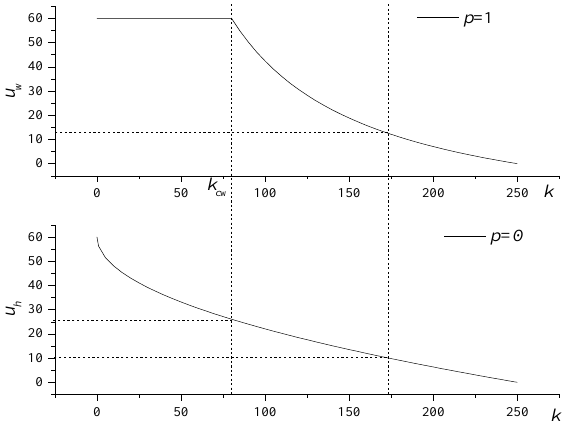
Figure 7. Speed-density diagram of p = 1 and p = 0.